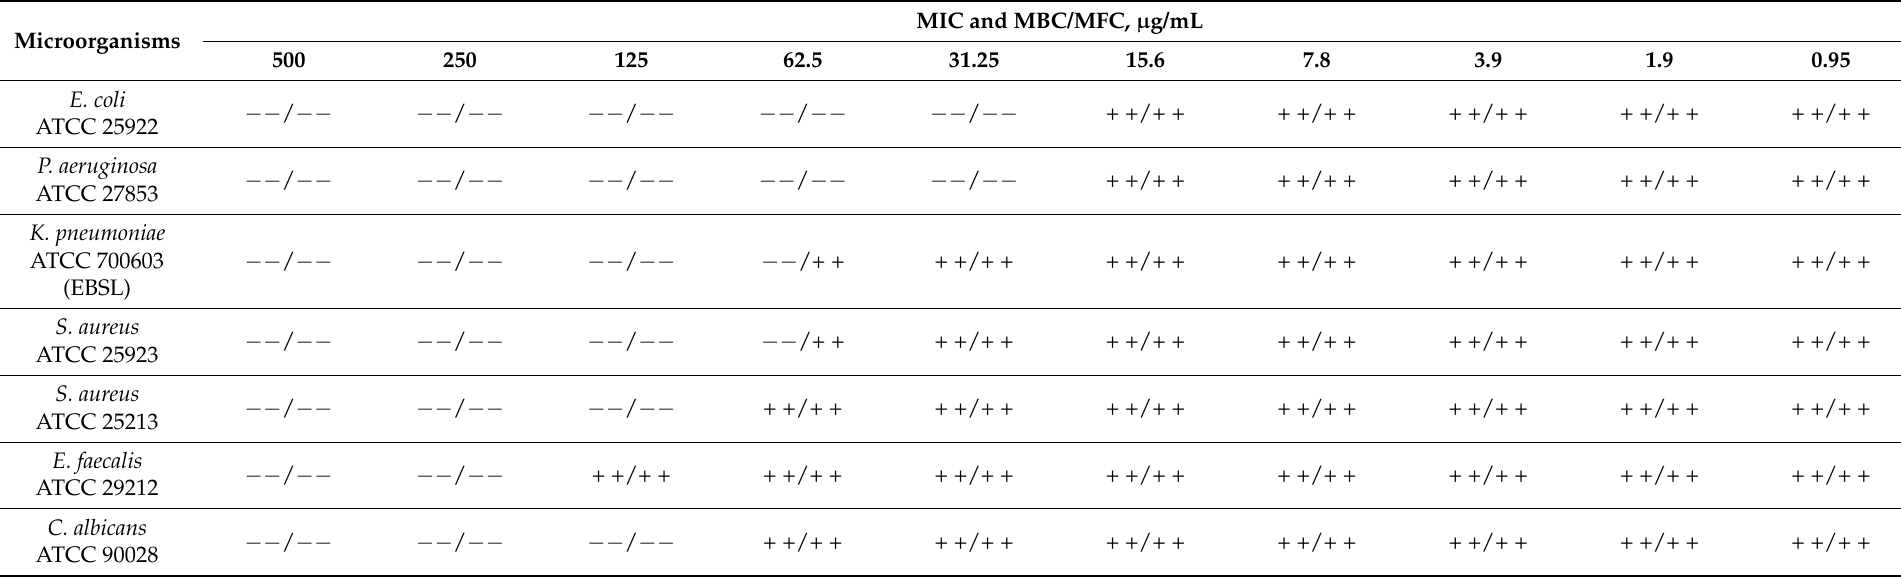
Table 1. Antimicrobial activity of freshly synthesized